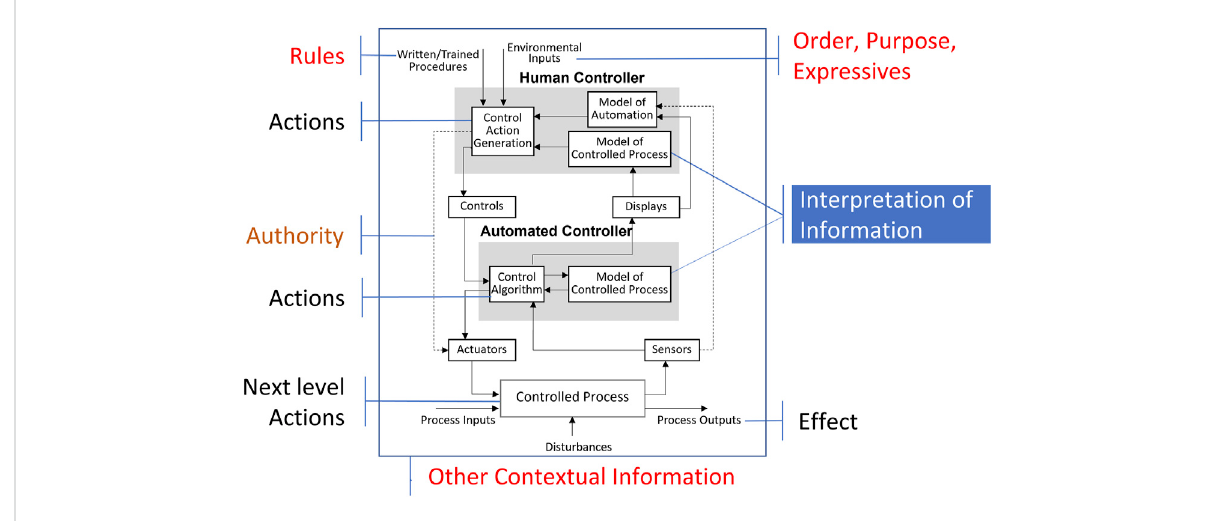
STPA control structure overlaid with the RECITAL ontology. Adapted from Cockcroft